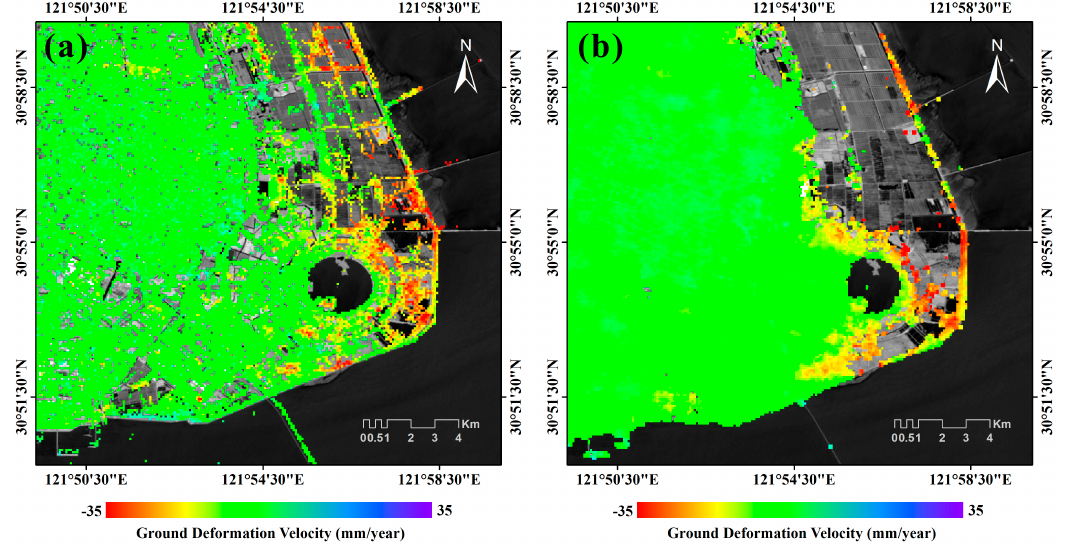
Figure 5. Lingang New City ground deformation. ( a ) Map of mean velocity calculated with the CSK vertical ground deformation time-series, from December 2013 to March 2016. ( b ) Map of mean velocity calculated with the RST-2 vertical ground deformation time-series, from January 2012 to October 2016.